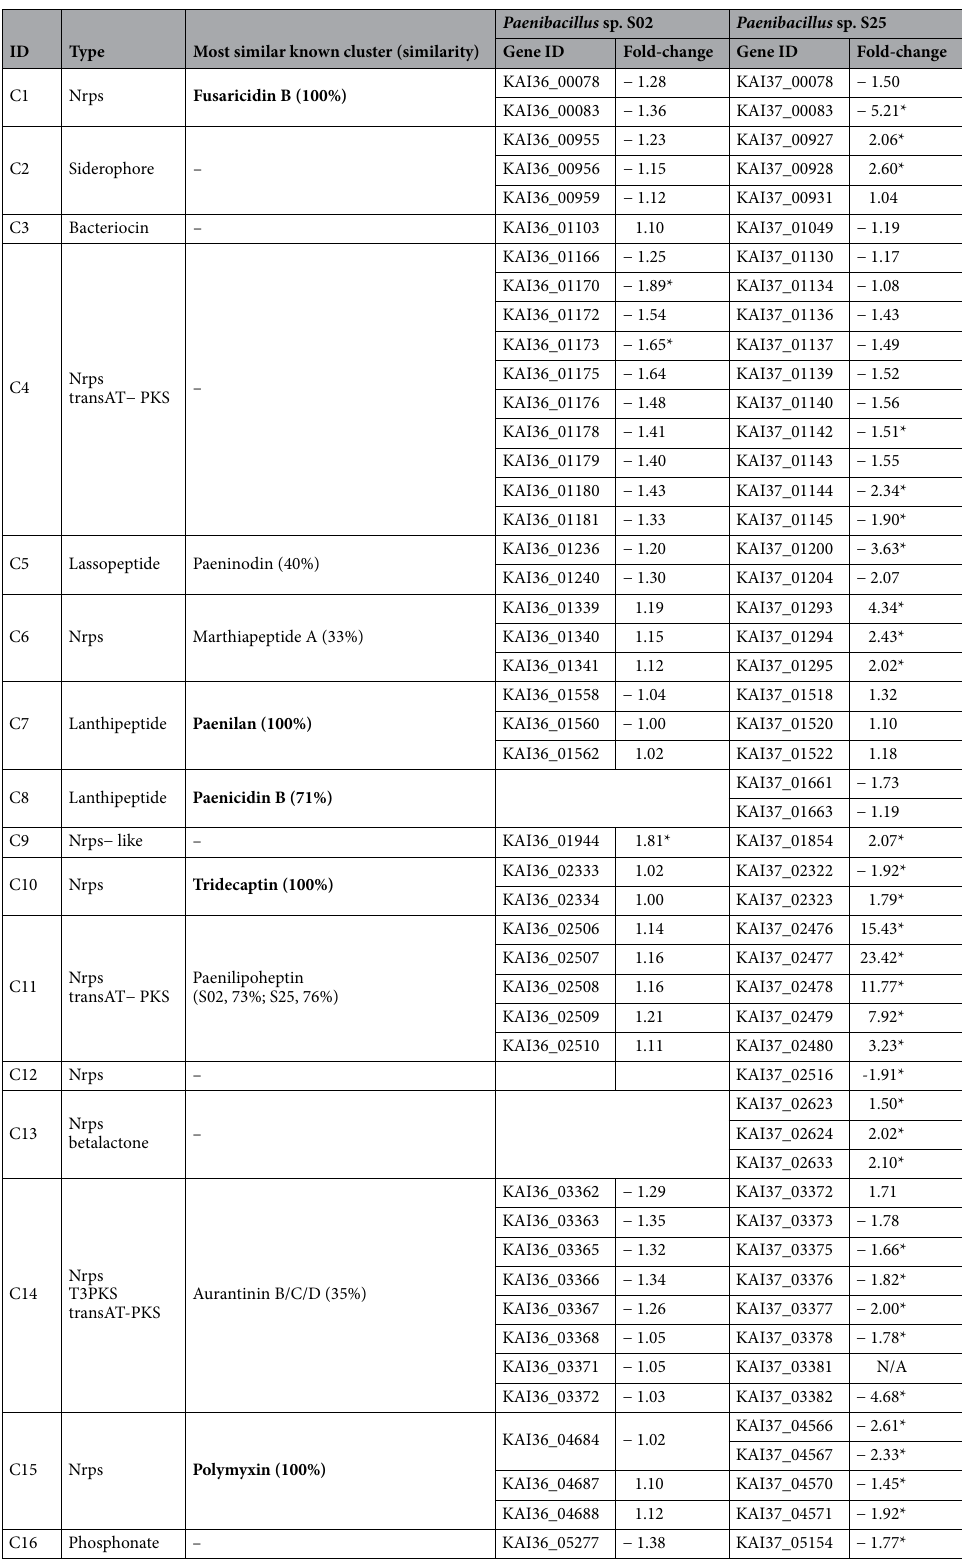
Table 4. Fold-changes in expression levels of the core biosynthetic genes of secondary metabolite gene clusters identify in Paenibacillus sp. strains S02 and S25 when F. verticillioides was present. Clusters in bold: Known antimicrobial compounds. N/A: Genes that didn’t pass the abundance filter described in “Transcriptome analysis” section. *: Genes that were differentially expressed ( q-value < 0.05 and absolute fold-change ≥ 1.5) when F. verticillioides was